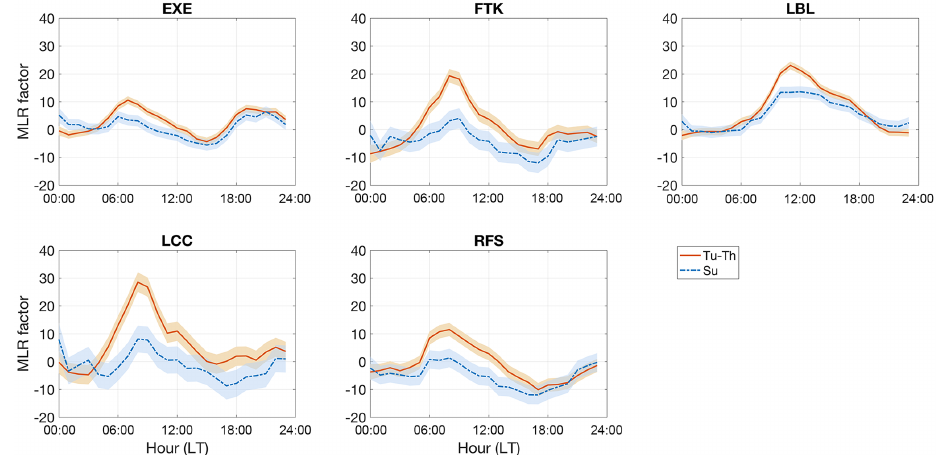
Figure 8. Multiple-linear-regression coefficients for five sites derived for each hour of the day on Tuesdays through Thursdays (orange solid line) and Sundays (blue dashed line) between 15 February 2017 and 15 February 2018.